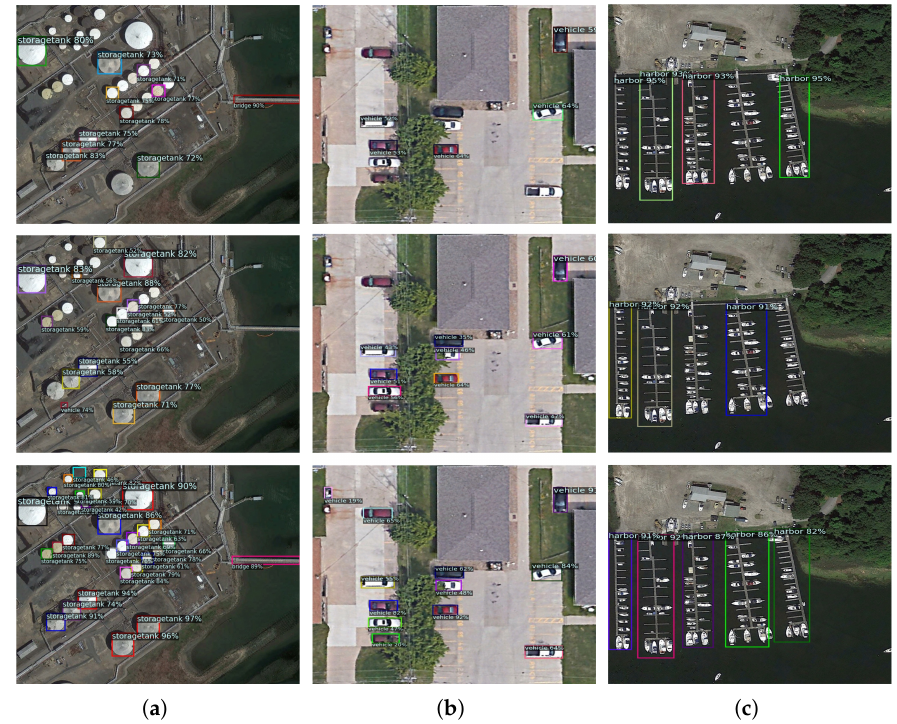
Figure 8. Qualitative inference results of base categories on the DIORdataset. ( a ) storage tank, ( b ) vehicle, ( c )